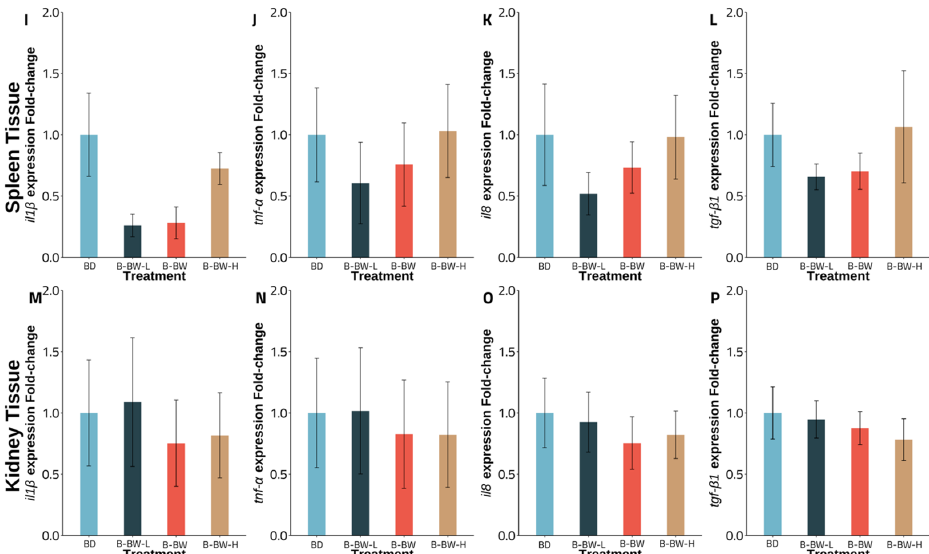
Figure 2. Gene expression of channel catfish from experiment B fed BiOWiSH probiotics diet, with three different probiotic inclusion levels (B-BW-L; n = 4, B-BW; n = 4, B-BW-H; n = 5), and a basal diet (BD; n = 5) during an 8-week period with the initial weight of 0.36 ± 0.03 g. Different letters indicate a significant difference ( p < 0.05). Bar graphs are presented as mean and error bars, as the standard error of the mean. BD = basal diet; BiOWiSH FeedBuilder Syn3 with low 1.8 × 10 4 CFU g − 1 (BW-L), recommended 3.6 × 10 4 CFU g − 1 (B-BW), and high 7.2 × 10 4 CFU g − 1 (B-BW-H) concentrations of B. subtilis . Figure ( I – L ): Expression of il1 β ( I ), tnf- α ( J ), il8 ( K ), and tgf- β 1 ( L ) of spleen tissue. Figure ( M – P ): Expression of il1 β ( M ), tnf- α ( N ), il8 ( O ), and tgf- β 1 ( P ) of kidney